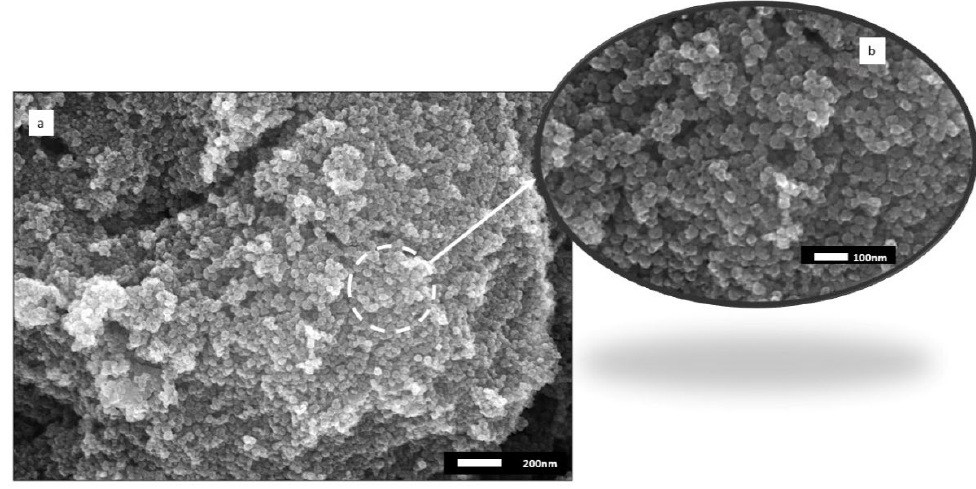
Figure 7. ( a ) SEM micrograph of a porous nanostructured agglomerate in the fractured cross-section of M-8; ( b ) high magnification SEM micrograph of the nanostructured agglomerates demonstrating the presence of unmelted/sintered TiO 2 nanoparticles.